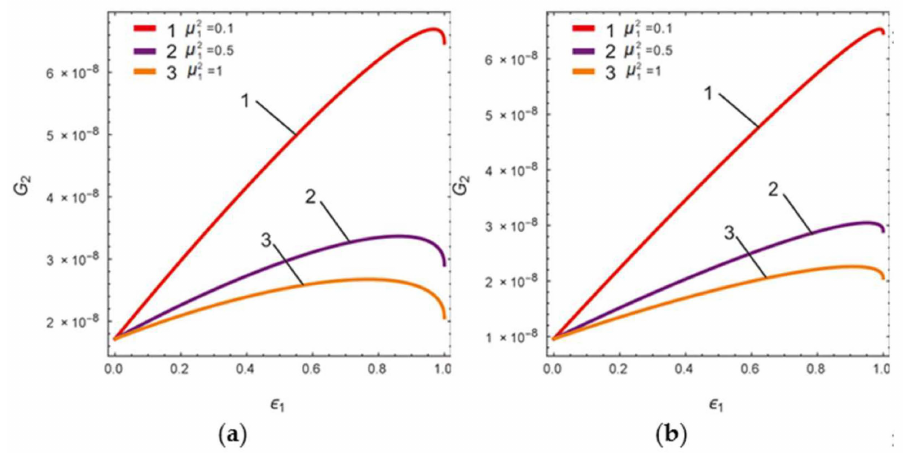
Figure 3. Gain G 2 versus FCP (cid:101) 1 curve: ( a ) B = 1, ( b ) B =